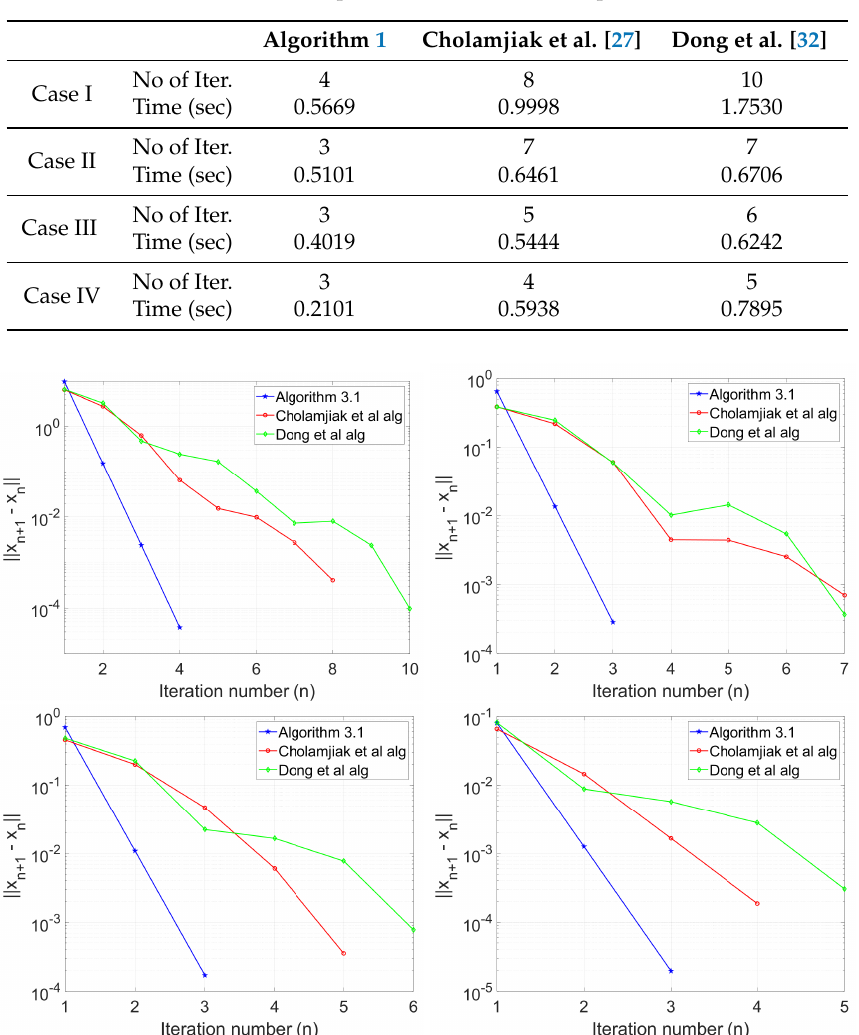
Figure 3. Example 3, Top Left: N = 5; Top Right: N = 10; Bottom Left: N = 30; Bottom Right: N =